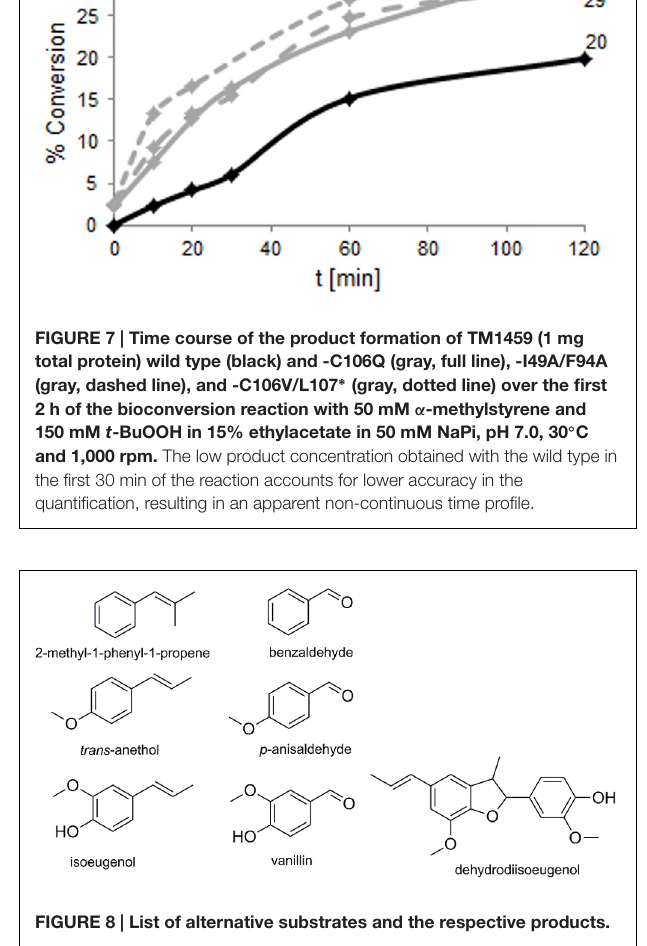
FIGURE 8 | List of alternative substrates and the respective